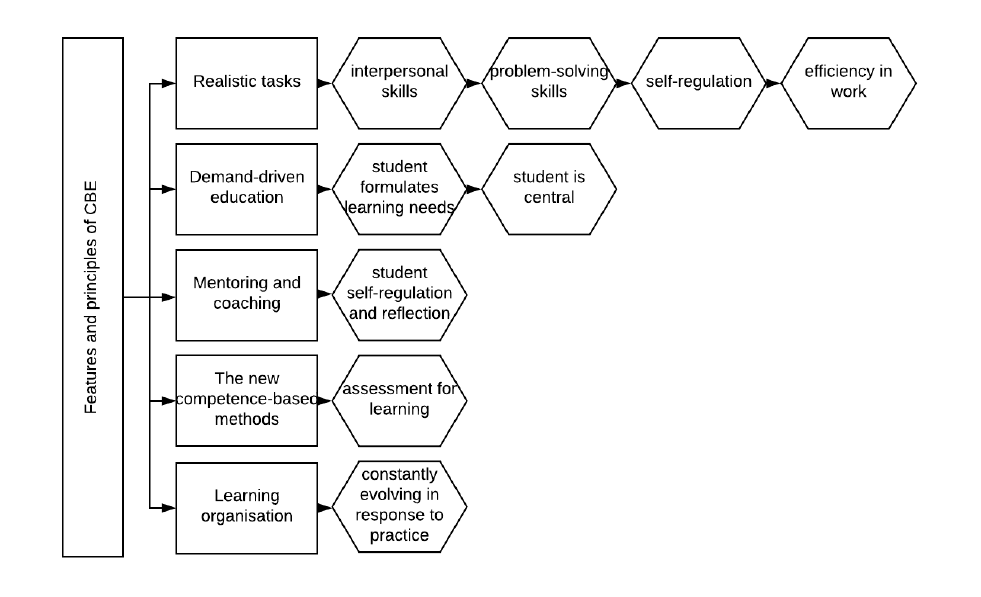
Fig. 1. Features and principles of